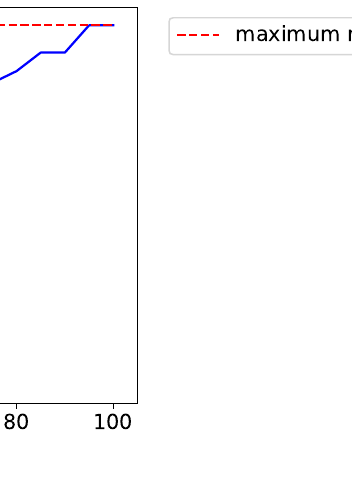
Figure 4. Trade-off between accepted delay and total stochastic